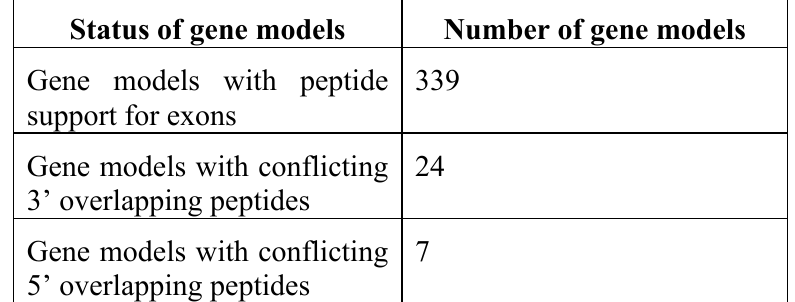
Table 3: According to our results, in total, 370 gene models had peptides mapped to them with 350 only containing peptides supporting the annotation. For other gene models supporting peptides may exist, but in addition peptides which conflict with the available annotation by either overlapping on the 3’ side or 5’ side with an annotated gene model were